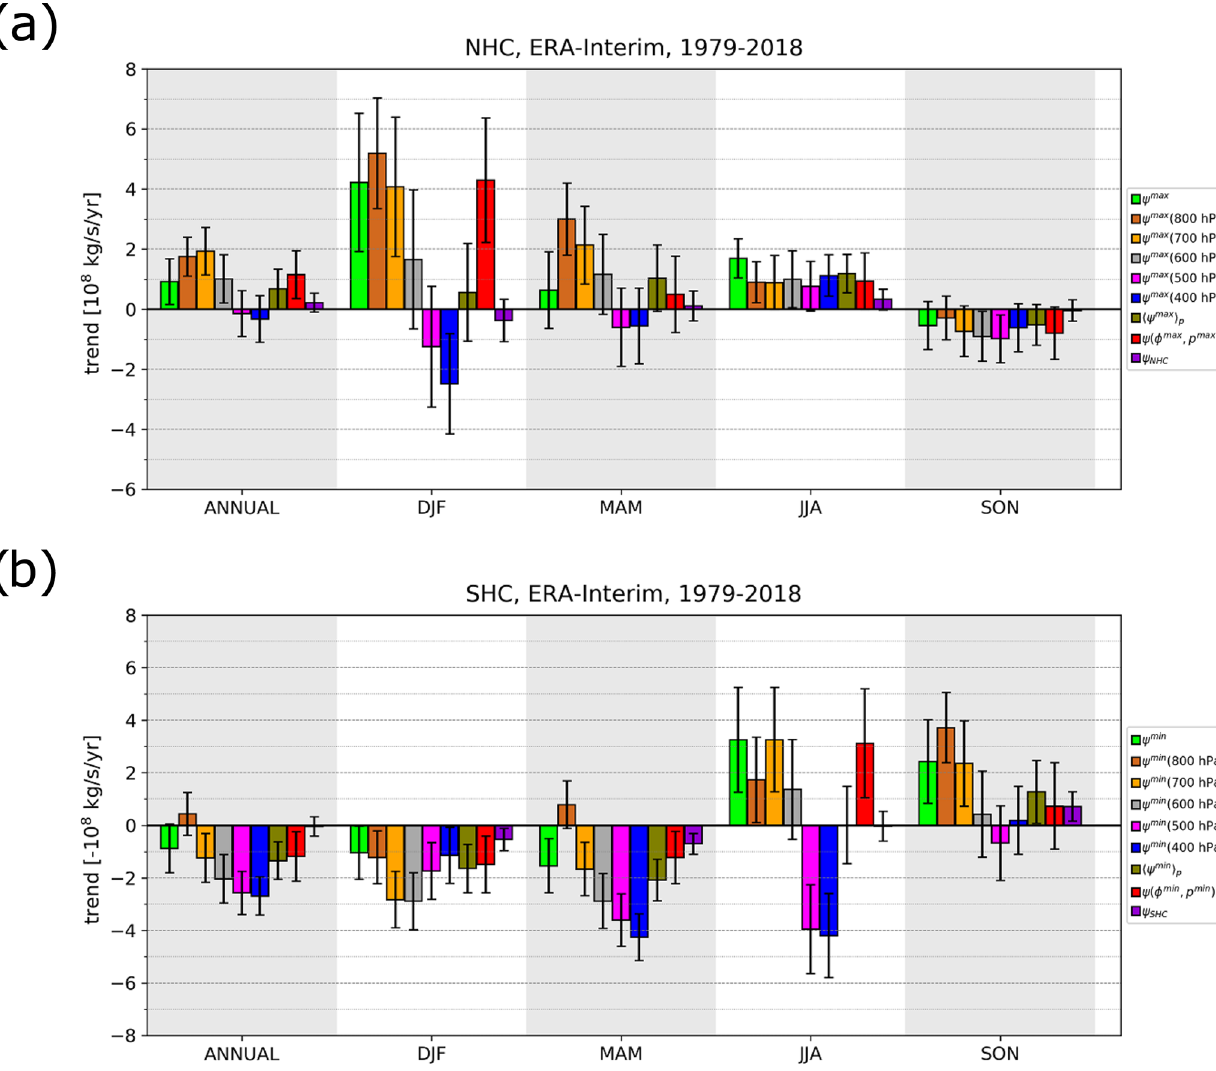
Figure A5. As in Fig. 2, but for the ERA-Interim